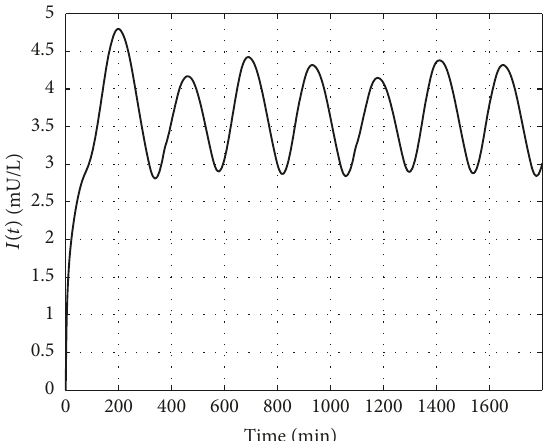
Figure 18: Variation of the blood insulin level over